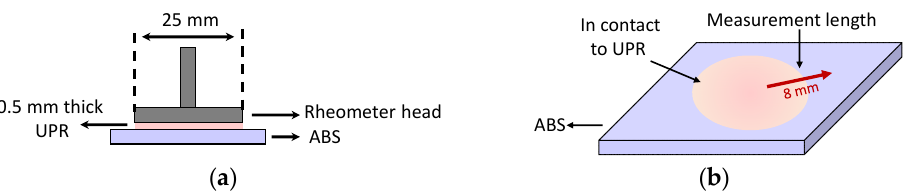
Figure 2. ( a ) Schematic view of the rheometer setup for the swelling experiments by placing UPR on ABS surface, and ( b ) measurement direction in confocal microscopy.